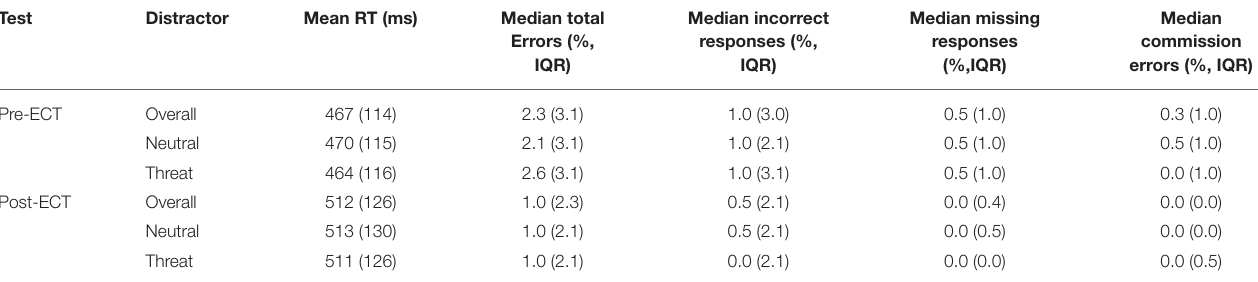
TABLE 1 | Performance in the Executive RT Test in the context of threat-related and neutral distractor pre- and post-ECT. Test